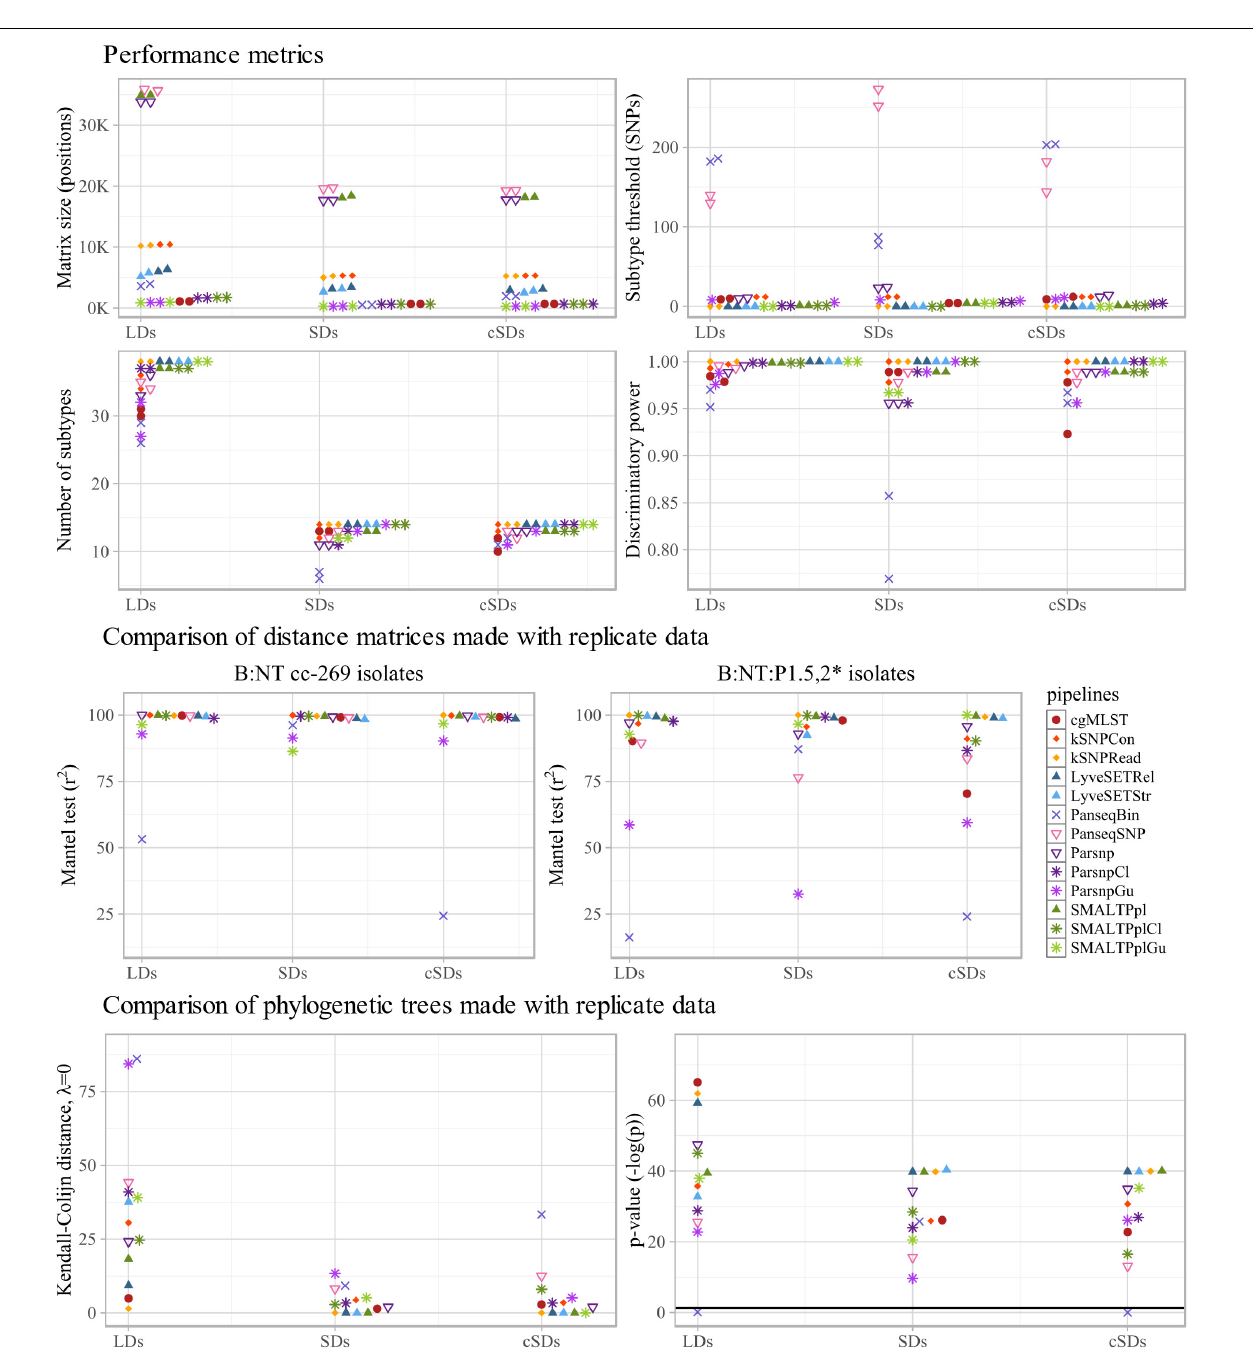
FIGURE 4 | Technical performance characteristics of subtyping workflows. Upper four panels: performance metrics of the tested pipelines, more specifically SNP/allele matrix size, threshold for differentiation between subtypes, the number of subtypes discriminated by the pipelines and the corresponding discriminative power (D) are shown. For each metric, the values calculated with the two large datasets (LDs), two small datasets (SDs) and two composite small datasets (cSDs) are displayed separately along the x-axis. Middle two panels: to assess stability of each pipeline to inter-run variability of sequencing data, distance matrices produced with replicate sequencing datasets were compared using Mantel test. The comparison was carried out between the two large datasets (LDs), the two small datasets (SDs), and the two composite small datasets (cSDs) (indicated on the x -axis), using all B:NT cc-269 isolates (left) , as well as a subset of more closely related isolates, B:NT:P1.5,2 ∗ (right) , and the resulting Spearman correlation coefficients ( r 2 ) were reported. Lower two panels: to further assess stability of each pipeline to inter-run variability of sequencing data, phylogenetic trees produced with replicate sequencing datasets were compared using the Kendall–Colijn (KC) test for topology ( λ = 0). The comparison was carried out between the two large datasets (LDs), the two small datasets (SDs), and the two composite small datasets (cSDs) (indicated on the x -axis), and the resulting KC values (right) and the corresponding p -values, expressed as -log(p) (left) , were shown. Thick horizontal line corresponds to p = 0.05